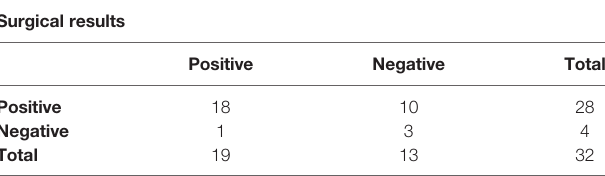
TABLE 2 | Frequency of true positive, false positive, true negative, and false negative macroscopic fi ndings during endoscopy.